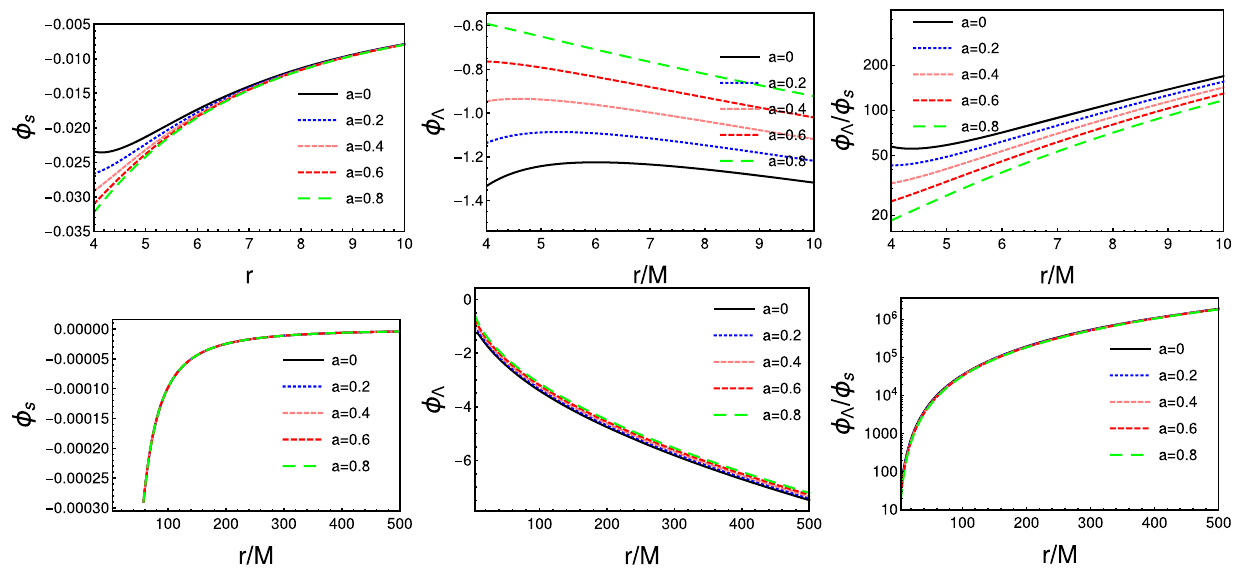
Fig. 2 Plots of the derivation angular frequency for circular orbit induced by particle’s spin and cosmological constant that how they depend on the radius. The top channel for the details in small radius range, the bottom channel for the details in large radius